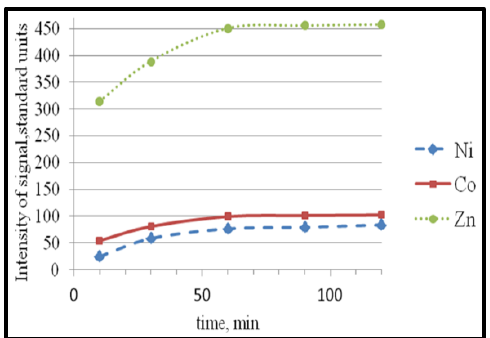
Figure 3. Selection of time for trace metal sorption concentration (intensity of signal is average for all types of sorbent).